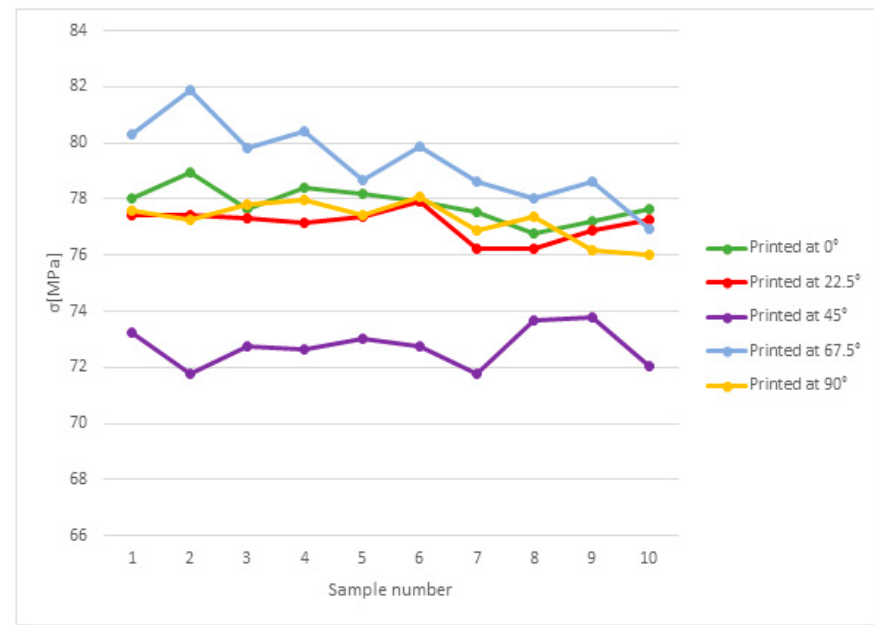
Figure 15. Maximal stress values for the respective samples, measured for pure